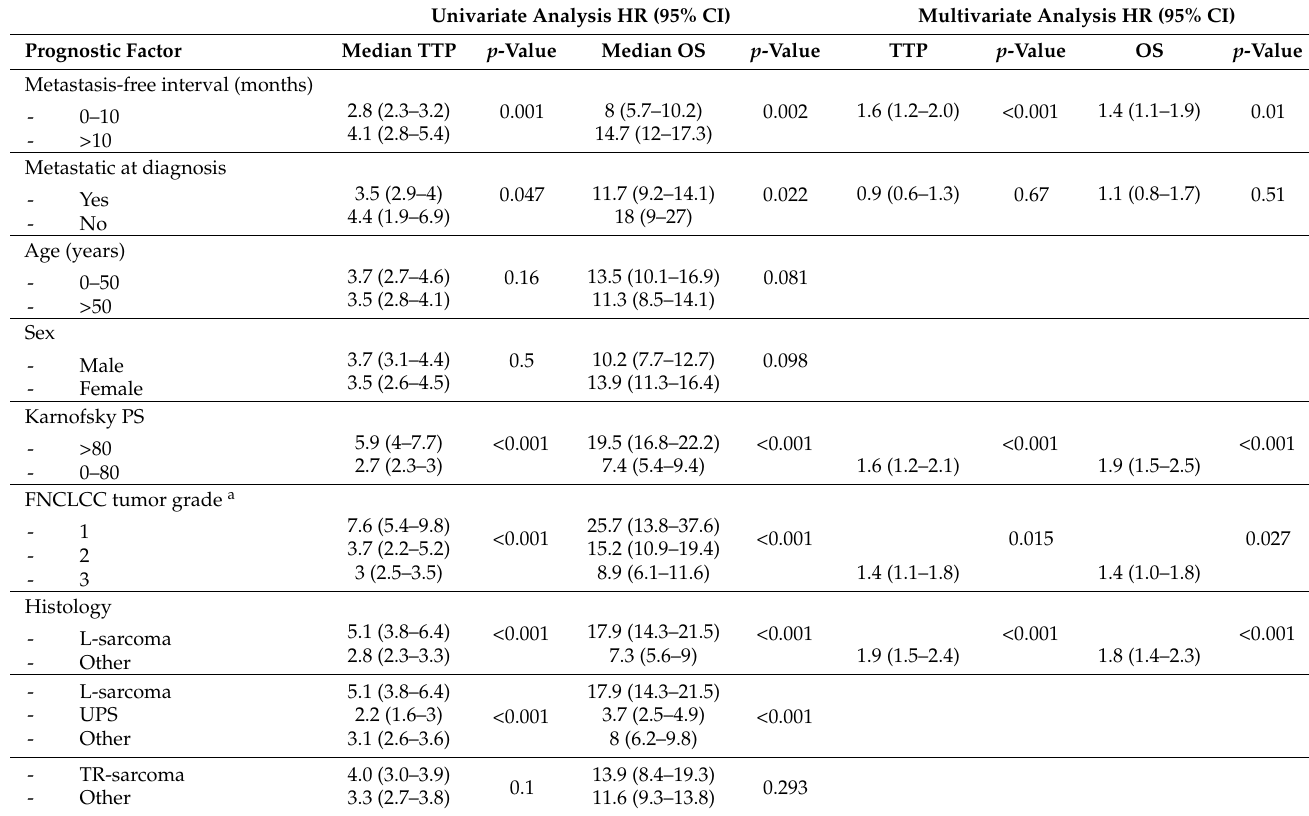
Table 2. Univariate and multivariate analysis of prognostic factors for worse TTP and